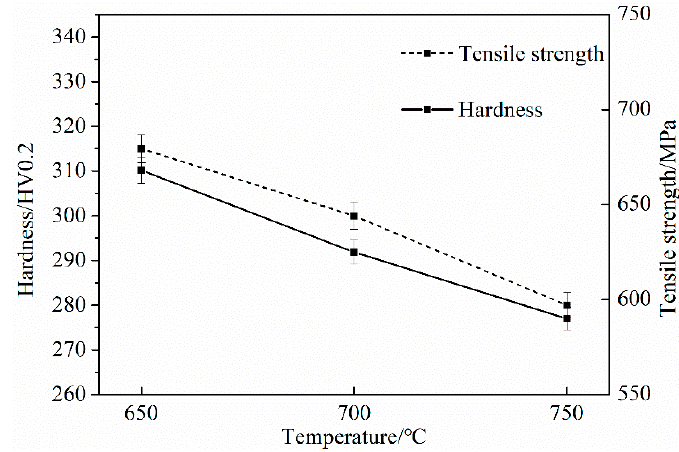
Figure 12. Tensile strength and microhardness of test steel.